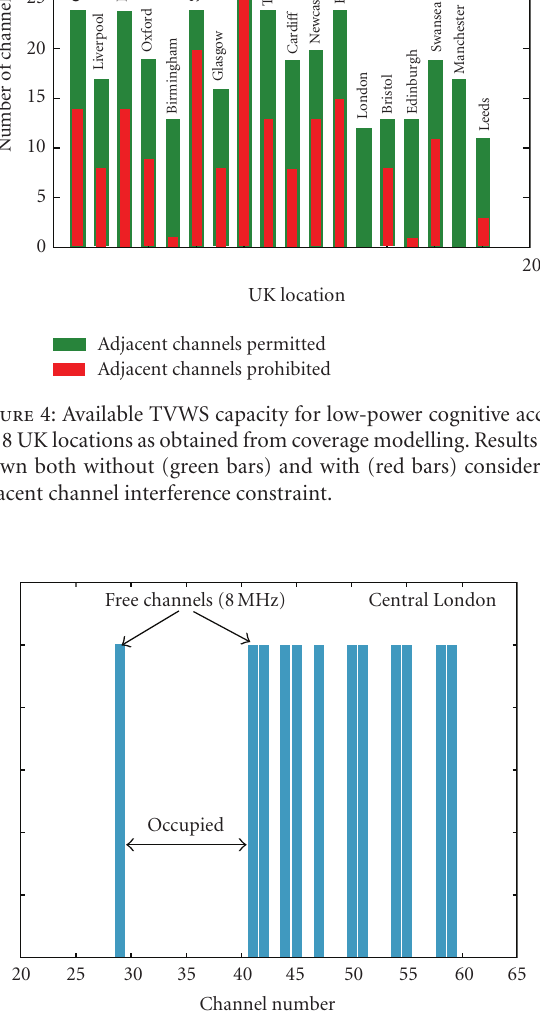
Figure 5: TVWS channels available for cognitive access in Central